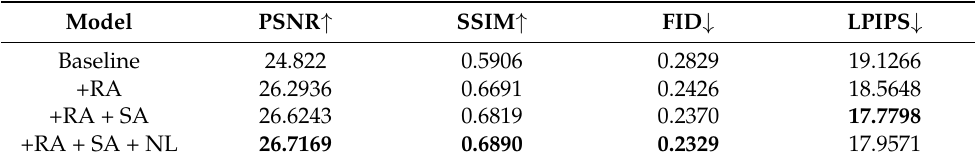
Table 5. The effect of gradual addition of different components on the performance of the model in relation to that of the baseline model. RA represents the region-aware strategy, SA represents the second-order channel attention mechanism, and NL represents the region-level non-local module. The bold represents the best value for each indicator.